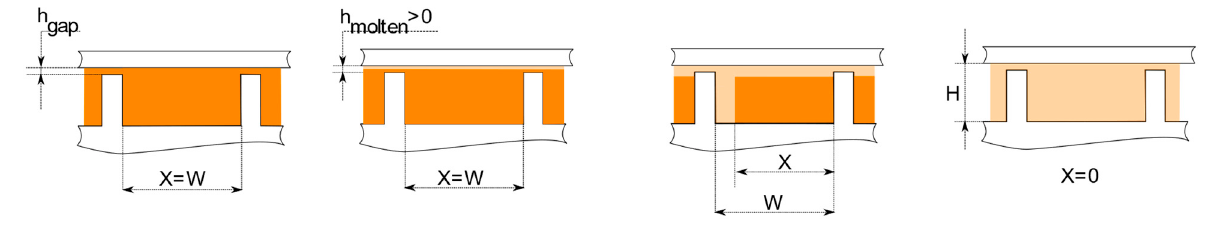
Figure 7. Maddock melting mechanism: W—channel width, H—channel height, h gap —radial clearance between screw flights and barrel, h molten —local molten layer thickness, X—local solid bed width.